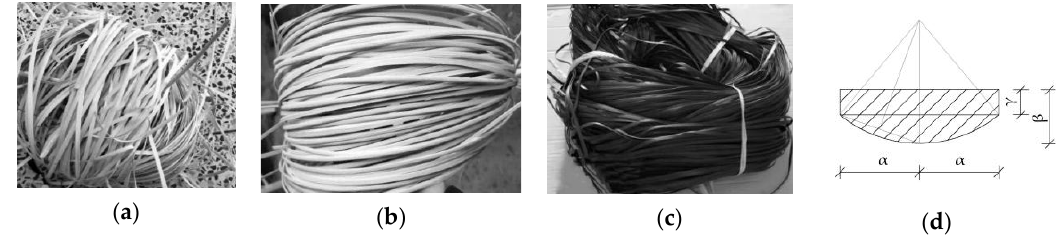
Figure 1. Physical appearance of evaluated bast ( a ), core ( b ), and synthetic ( c ) rattan strips and their cross ‐ section geometry ( d ).